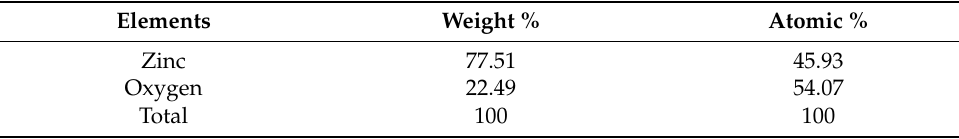
Figure 2. SEM images at ( a ) low, ( b ) high magnification, ( c ) EDX spectrum, ( d ) TEM image, and ( e ) particles distribution histogram of ZnO-NPs biosynthesized using extract of C. chinense fruits. Table 1. Elemental composition of Zn and O.